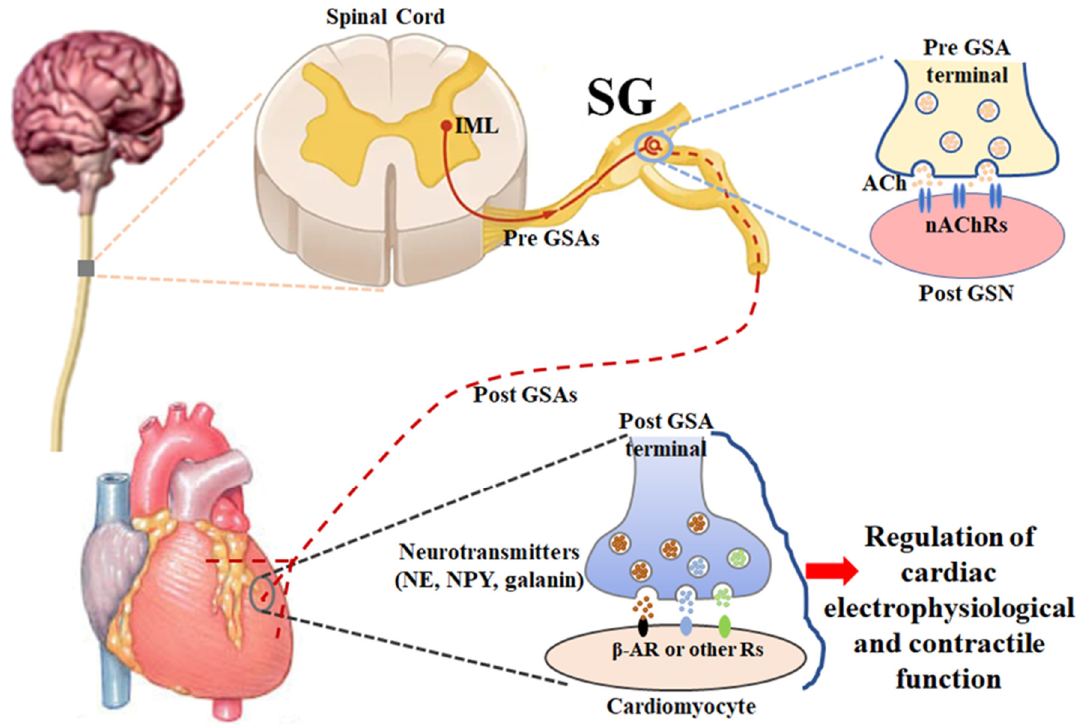
Figure 1. A schematic diagram illustrating the anatomy and physiology of stellate ganglia. ACh: acetylcholine; β -AR: β -adrenergic receptor; IML: intermediolateral nucleus; nAChR: nicotinic acetylcholine receptor; NE: norepinephrine; NPY: neuropeptide Y; Pre GSA: preganglionic sympathetic axon; Post GSA: postganglionic sympathetic axon; Post GSN: postganglionic sympathetic neuron; SG: stellate ganglion.